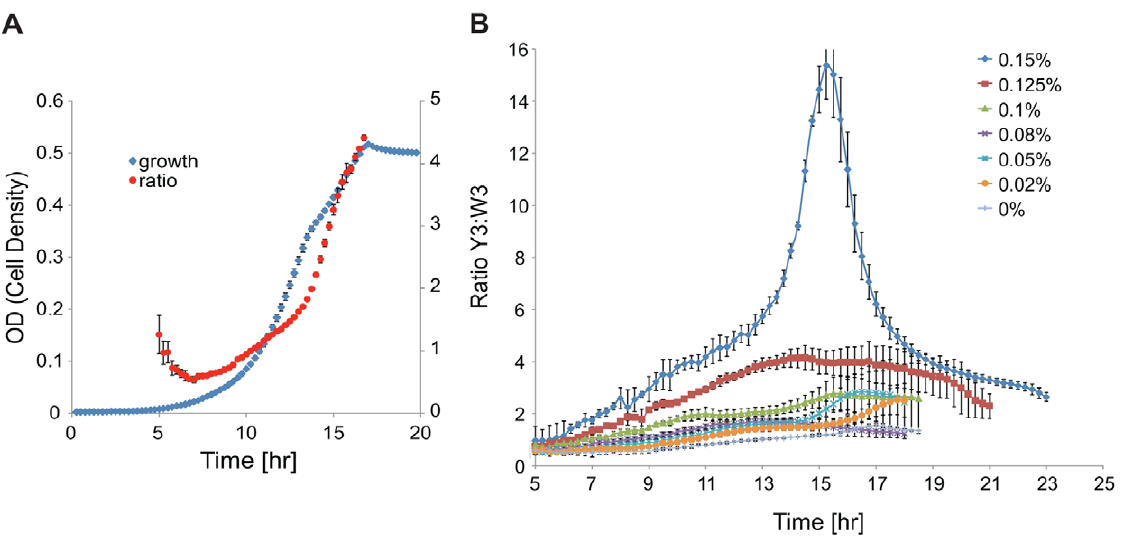
Figure 2. Co-culture growth and ratio dynamics: baseline and with tuning. ( A ) Co-culture density (measured by OD 600 ) and Y3:W3 ratio during growth in minimal medium without inducers. The ratio measurement is shown only for the exponential growth phase because the YFP calibration is not reliable after the cells enter the stationary phase. ( B ) An example of Y3:W3 ratio dynamics at various arabinose concentrations. Propionate concentration was held at 20 mM. Only the exponential growth phase is shown. Each curve represents the mean of 4 replicates. Note: the secondary y-axis label in ( A ), Ratio Y3:W3, is also the label for the primary y-axis in ( B ).